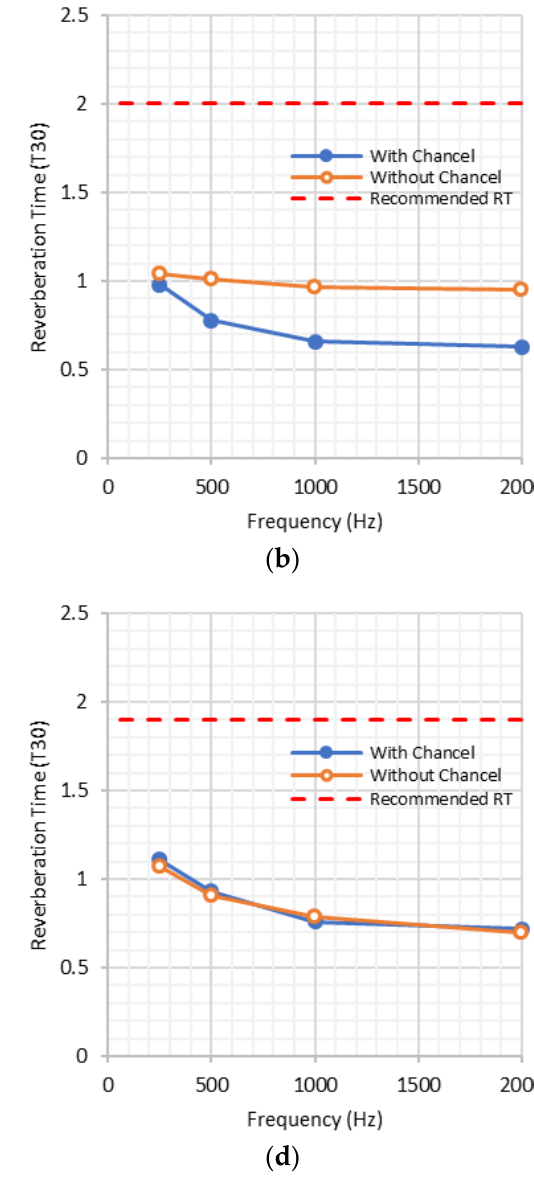
Figure 3. Comparison of the average RT between the simulations with a chancel and without a chancel: ( a ) C1; ( b ) P1; ( c ) P2; ( d ) R1.